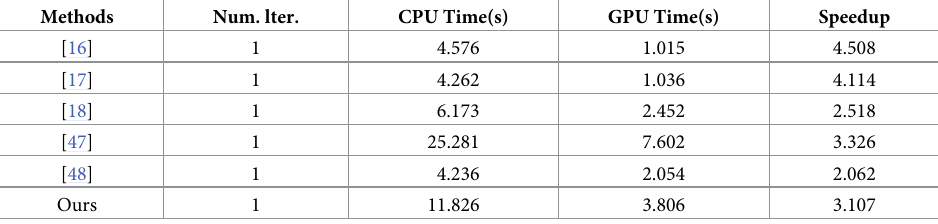
Table 10. Comparison of calculation speed. The data in Table 10 is the average running time of each image on the CPU/GPU, which is obtained by dividing the total time spent on testing the six models on the ILSVRC2012 by the total number of